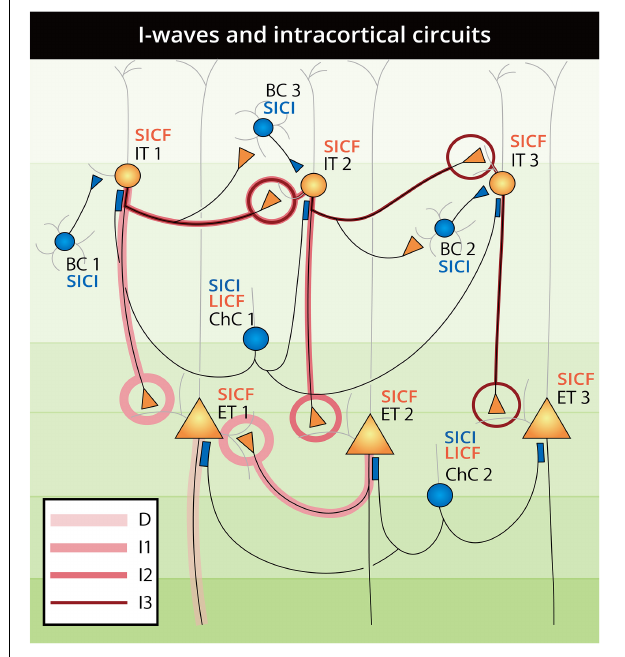
FIGURE 4 | Schematic landscape of D-wave and I-wave generation and paired-pulse SICI, SICF, and LICF intracortical circuits. Neurons are constructed and labeled as in Figure 2 and are numbered to illustrate the pathways of D-waves and I-waves. D-waves arise from the direct firing of ET neurons, as lined from the axon of ET1. The I1-wave is generated through the IT1-ET1 and ET2-ET1 types of circuit with one synaptic connection, which accounts for the ∼ 1.5 ms lag after the D-wave. Accordingly, the I2-wave is generated through the IT1-IT2-ET2 type of circuit with two synaptic connections, and the I3-wave is generated from the IT1-IT2-IT3-ET3 pathway with three synaptic connections. As the suprathreshold TMS pulse activates all neurons at the same time, the arrival of BC1 inhibition to the IT1 neuron lags one synaptic delay after the first firing of the IT1 neuron (generating the I1-wave), and can therefore explain the SCEP evidence of no inhibition of the I1-wave in the inhibitory protocols. Subsequently, with the regulation of INs, the I2- and later I-waves can be selectively suppressed by a timing-matched subthreshold pulse and displayed as SICI. When the influence of ChC at the AIS turned from inhibition to disinhibition (excitation) in the 8–30 ms time window, the outcome shifts consecutively from inhibition (SICI) to facilitation (LICF). As SICF selectively recruits the residual EPSPs from the unfired IT and ET neurons at a short latency, the regulation of INs may be eliminated by the second pulse arriving at the firing interval of the highly synchronous fast-spiking BCs and